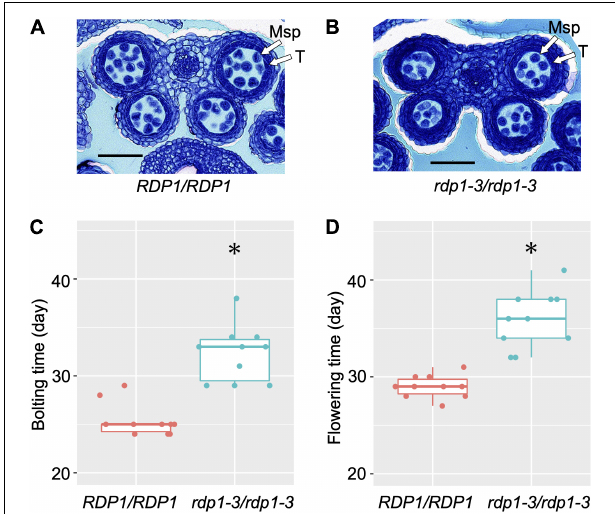
FIGURE 1 | Anther sections, bolting time, and flowering time of wild-type ( RDP1/RDP1 ) and null mutant ( rdp1-3/rdp1-3 ) plants. Transverse sections of RDP1/RDP1 (A) and rdp1-3/rdp1-3 (B) anthers (anther stage 8). Msp, microspores; T, tapetum. Scale bars, 50 µ m. Bolting (C) and flowering (D) time of RDP1/RDP1 and rdp1-3/rdp1-3 plants ( n = 10 and 10 for C,D , respectively; Asterisks indicate significant differences, determined by Wilcoxon rank-sum test, P = 4.33e–05 for C , P = 1.08e–05 for D ). Boxplots (C,D) show center line: median; box limits: upper and lower quartiles; dots: individual data points.